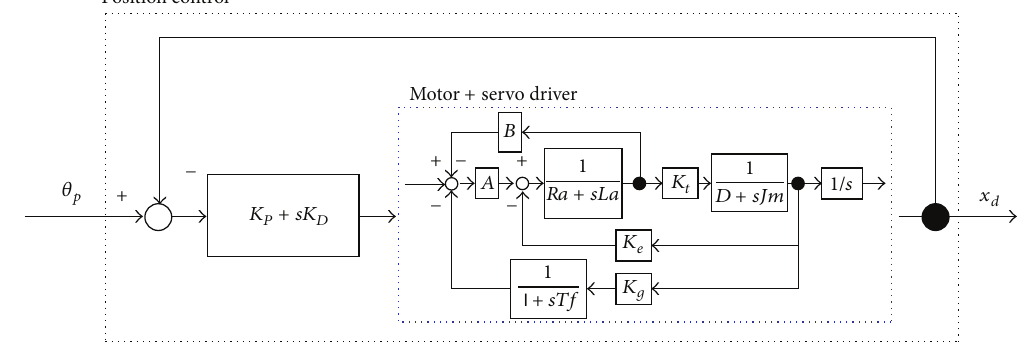
Figure 8: Position control scheme for WABIAN-2’s arm.